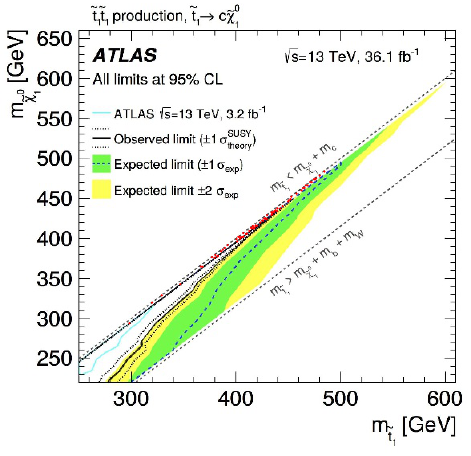
Figure 3 . Layered illustration of the by the small red points) superimposed upon the ATLAS Collaboration exclusion curve plot on t 1 t 1 production in the monojet search region for the channel χ 0 e e